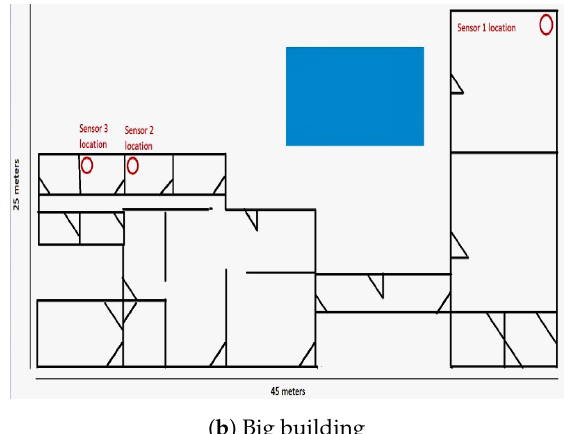
Figure 7. Floor Plans for small and large residential units used in experiments.